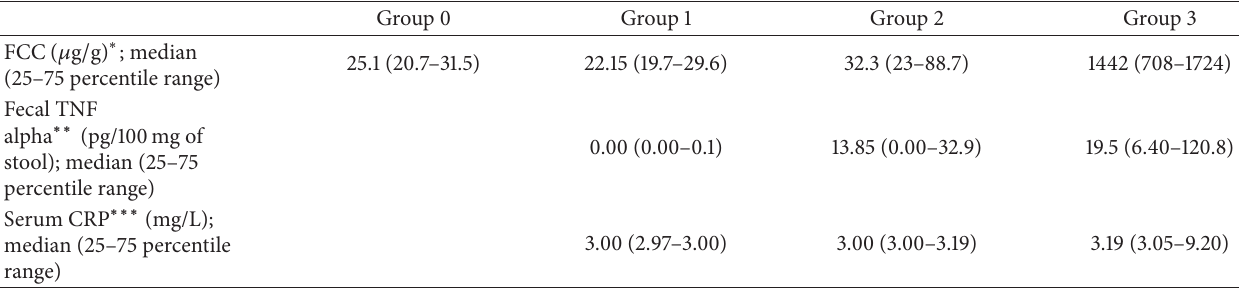
Table 1: Comparison of fecal calprotectin concentration (FCC), fecal tumor necrosis factor (TNF) alpha and serum C-reactive protein (CRP) levels in the study groups.